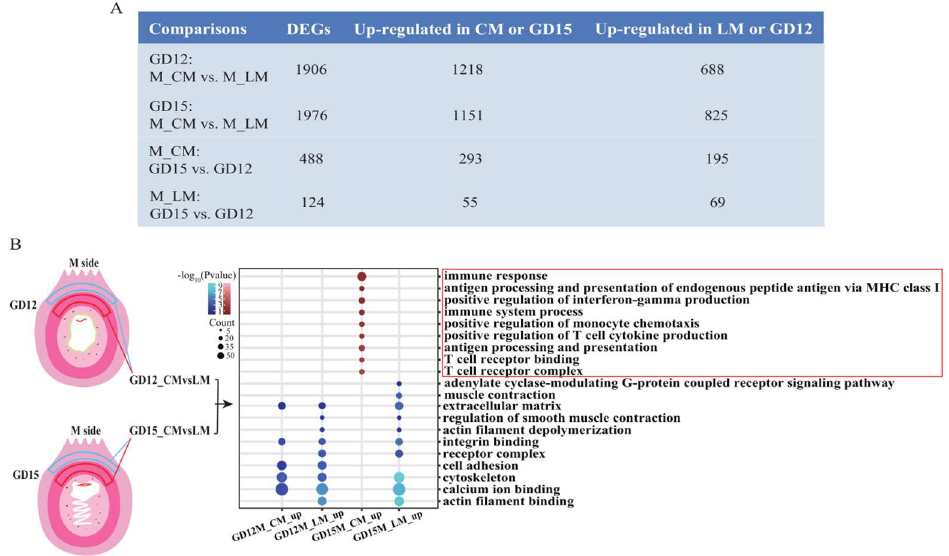
Figure 1. Transcriptional signatures in the M_CM and M_LM on GD12 and GD15 in pigs. ( A ) Identification of DEGs between M_CM and M_LM on GD12 and GD15. ( B ) GO analysis of DEGs between M_CM and M_LM on GD12 and GD15. GD12, day 12 of pregnancy; GD15, day 15 of pregnancy; M, the mesometrial side of the uterus; CM, the circular muscle of myometrium; LM, the longitudinal muscle of myometrium; DEGs, differentially expressed genes.